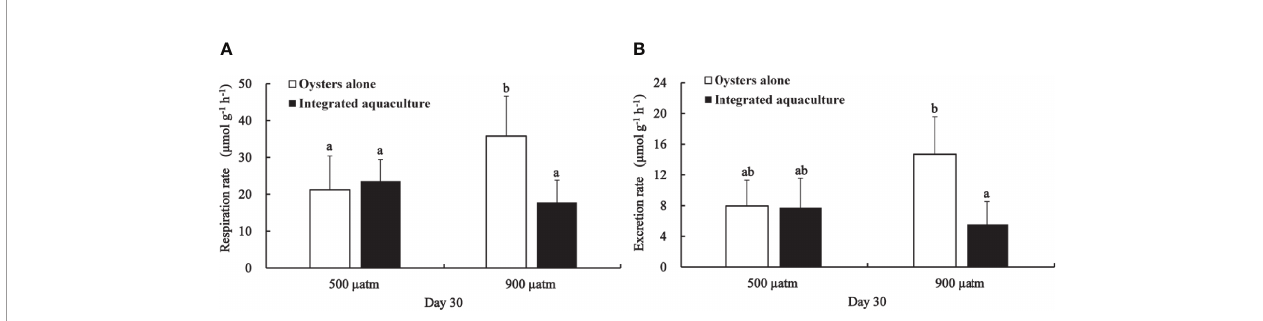
FIGURE 5 | Respiration rate (A) and ammonia excretion rate (B) of C . gigas exposed to different treatments for 30 days. Means ± SD are shown. Different letters indicate signi fi cant variation between treatments ( P